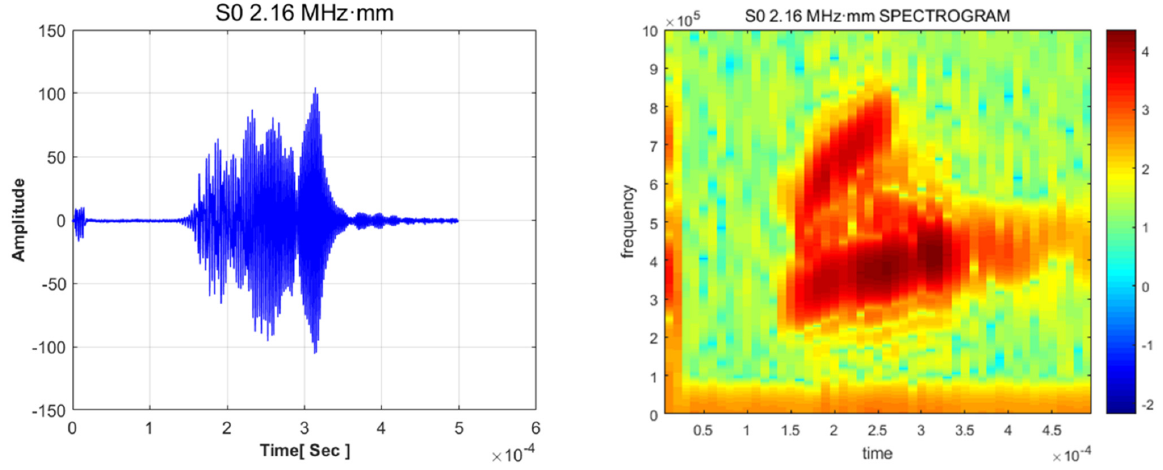
Figure 7. The mode identification process of Lamb waves considering group velocity, frequency, and superposition effect.